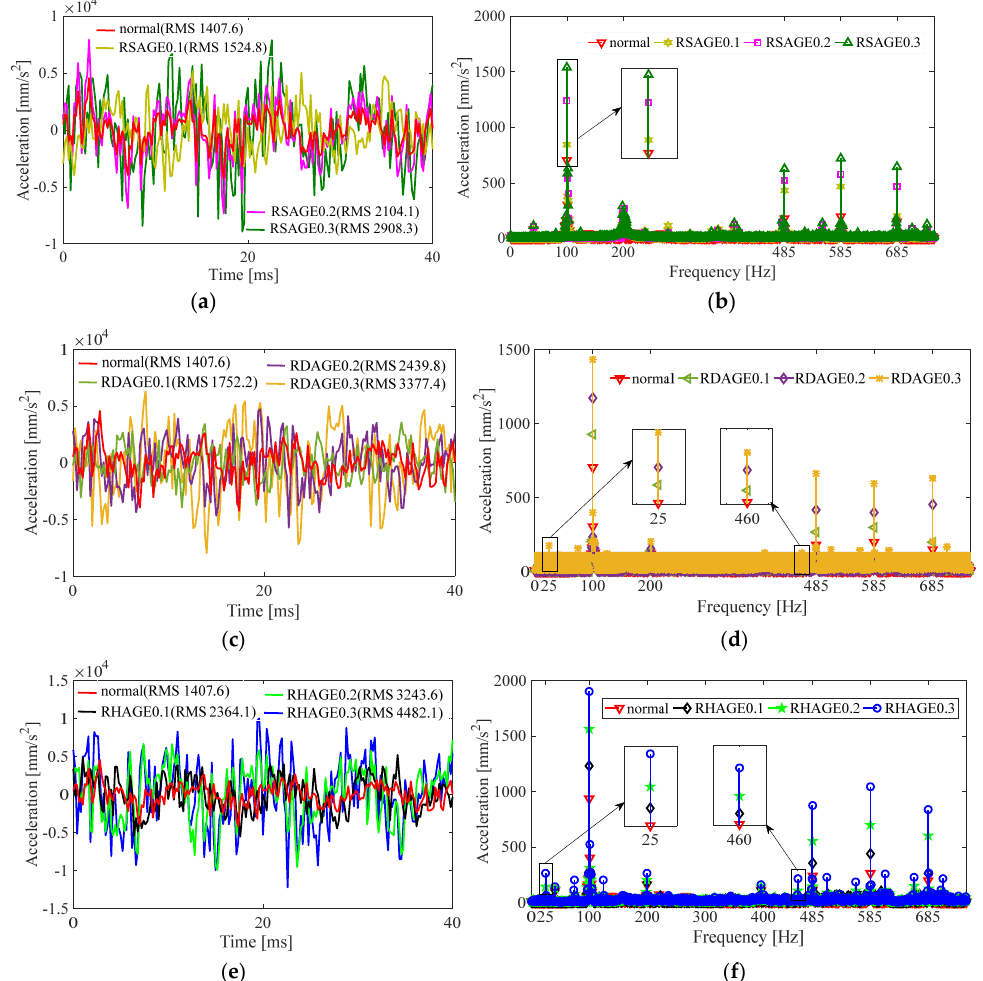
Figure 7. The end winding vibration by experiment: ( a , b ) the time domain and frequency domain in RSAGE; ( c , d ) the time domain and frequency domain in RDAGE; and ( e , f ) the time domain and frequency domain in RHAGE.